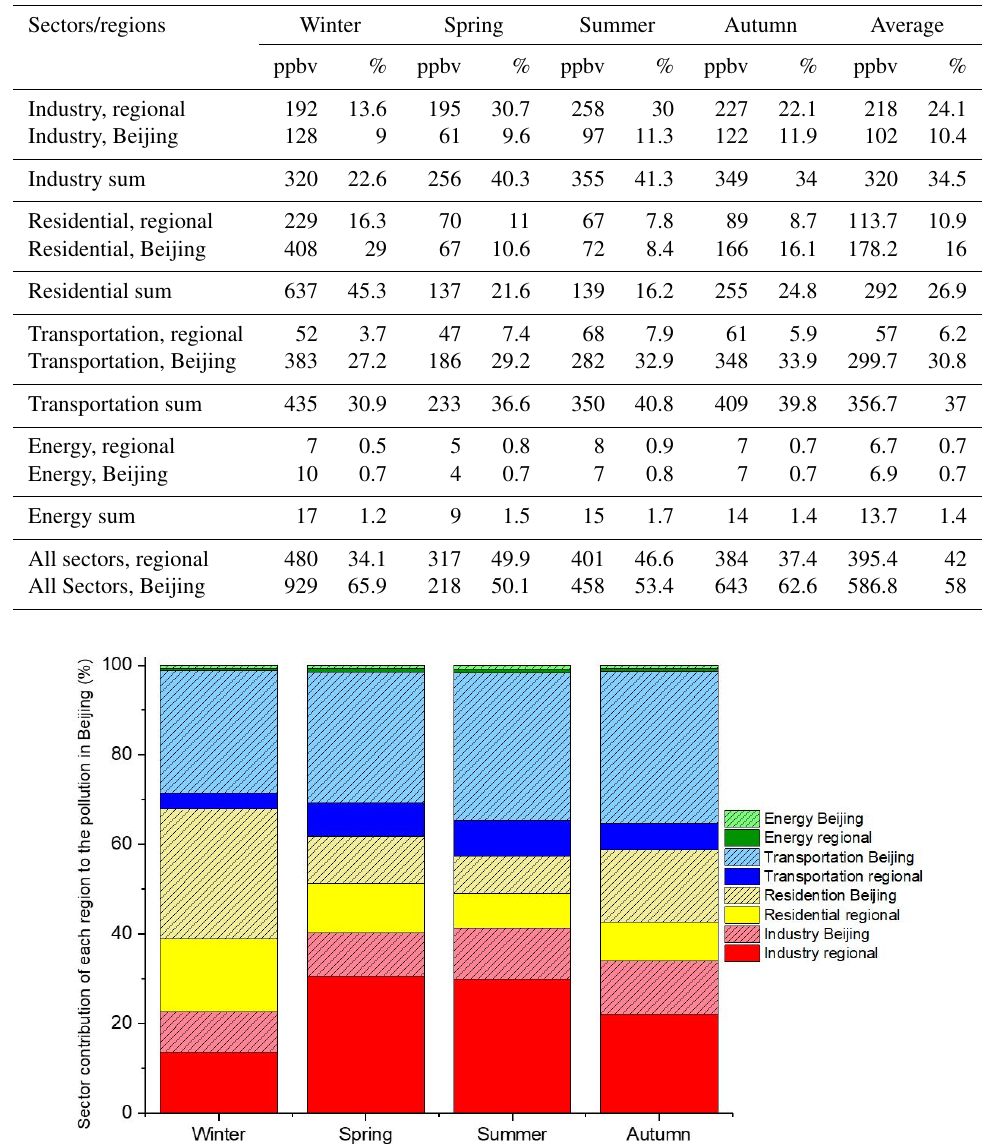
Figure 8. Sector contribution from outside Beijing and within